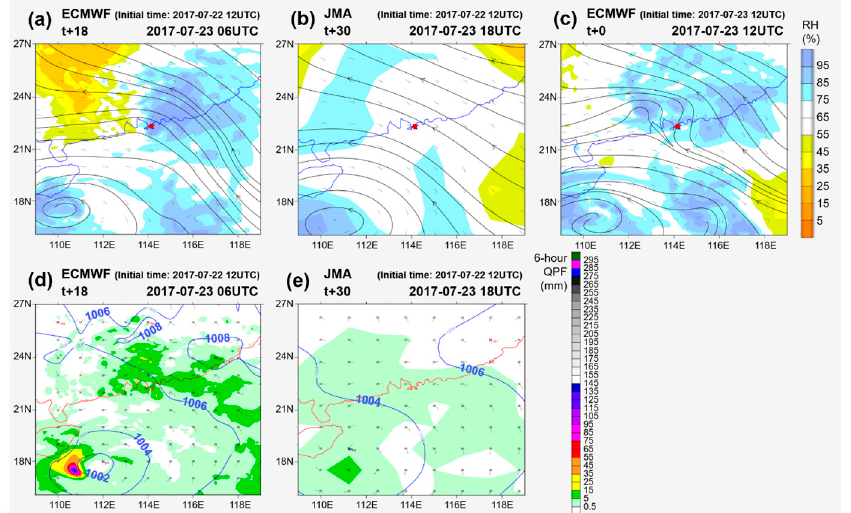
Figure 12. ( a , b ) The predicted 500 hPa moisture (Relative Humidity (RH) shaded) and wind fields (streamlines) of ( a ) ECMWF, ( b ) JMA with base time and forecast time stated in the figures. ( c ) Ground truth based on ECMWF analysis field of 23 July 12 Z (UTC). ( d , e ) The 6 h QPF (shaded) from ( d ) ECMWF and ( e ) JMA correspond to the mid-level patterns in (a) and (b), respectively. Lines represent isobars.